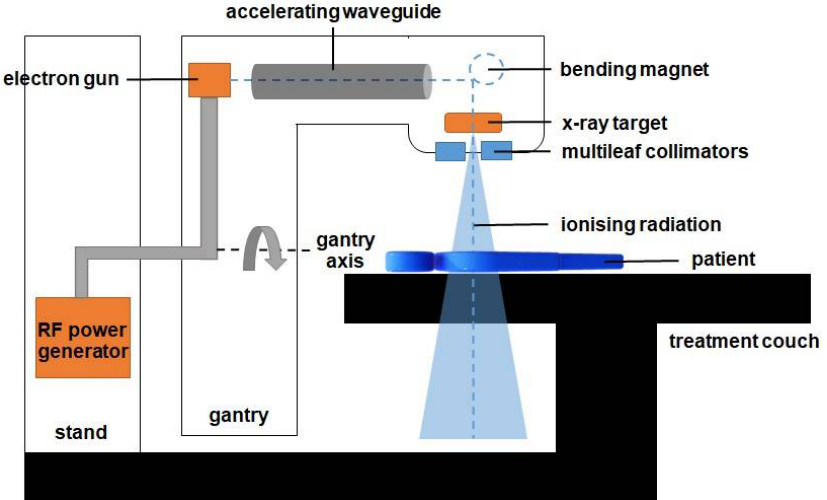
Figure 1. The diagram of components in the linac. The gantry is rotated to deliver the radiation from various angles to produce a 3D volumetric dose inside the patient. The beam is shaped using a set of multileaf collimators and delivered externally to the patient to kill the cancer cells inside the body.